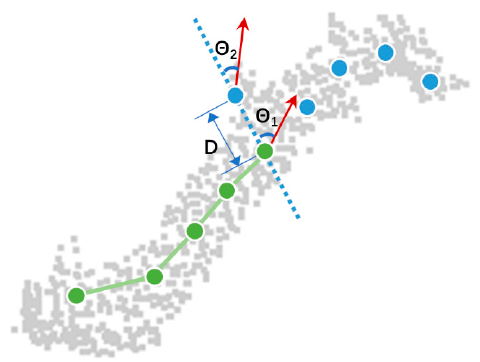
Figure 4. An illustration of similarity score composition. Gray points are example of scanned branch points, green dots are connected nodes, blue dots are candidate nodes to a target node, 𝐷 is distance between target node and one of the candidate nodes, and 𝜃 is included angle between their connection (dashed line) and node direction (red arrow). For clarity, fitted circles around each node are not shown here.